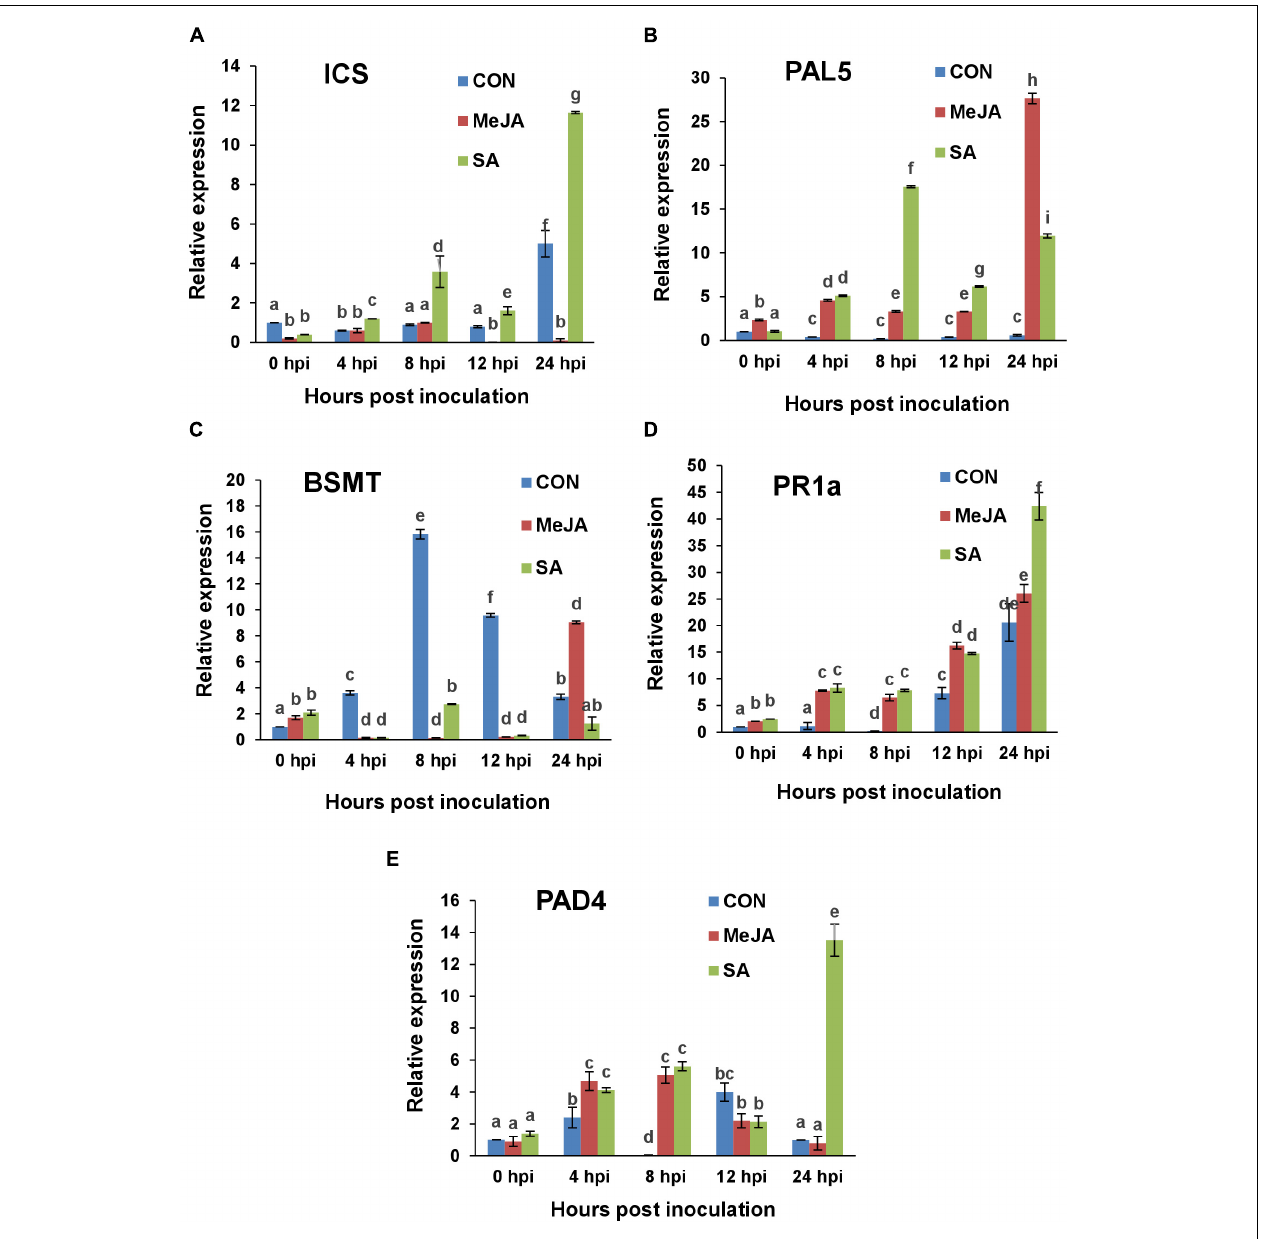
FIGURE 15 | RT-qPCR analysis of the expression of Salicylate signaling marker genes in primed and control plants post infection with R. solani . Graphs of Quantitative real-time RT-PCR analysis of genes over a time course in the first 24 h after infection: (A) Isochorismate synthase ( ICS ), (B) Phenylalanine ammonia lyase 5 ( PAL5 ), (C) Salicylate/benzoate carboxyl methyltransferase ( BSMT ), (D) Pathogenesis-related protein-1a ( PR1a ), (E) Phytoalexin-deficient 4 (PAD4 ). Bars represent standard error (SE) of the mean ( n = 3). Different letters indicate significant differences among treatments at p < 0.05, according to Duncan’s multiple range